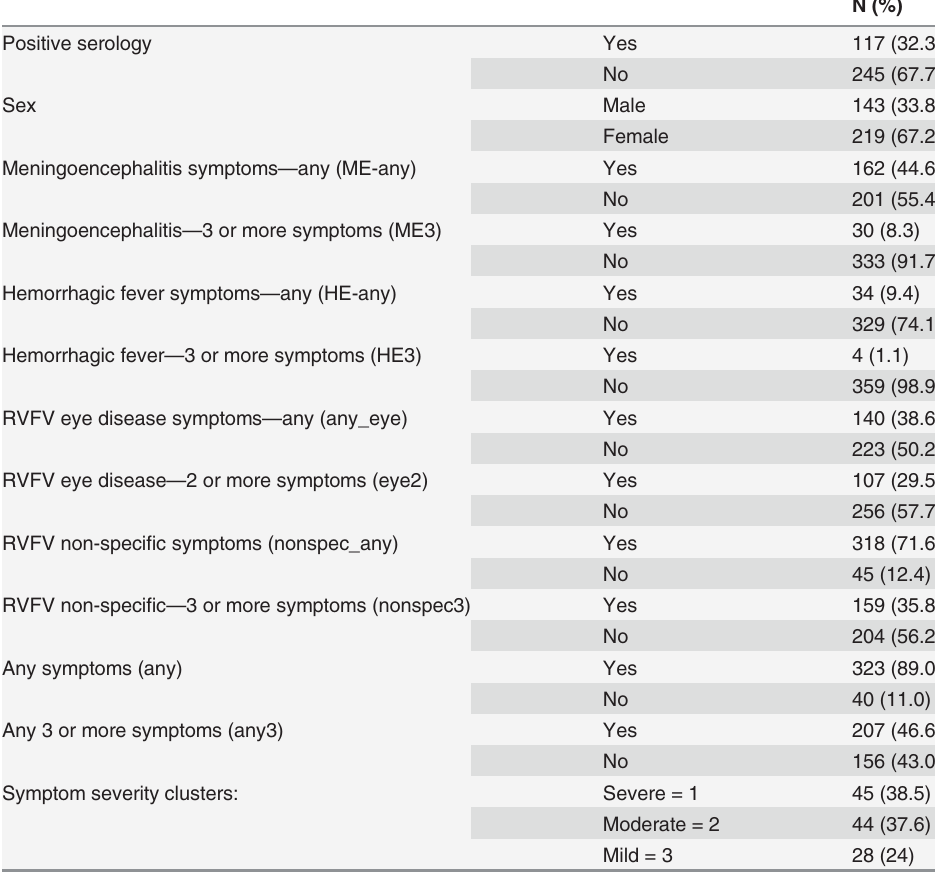
Table 1. Patient demographics and distribution of clinical phenotype